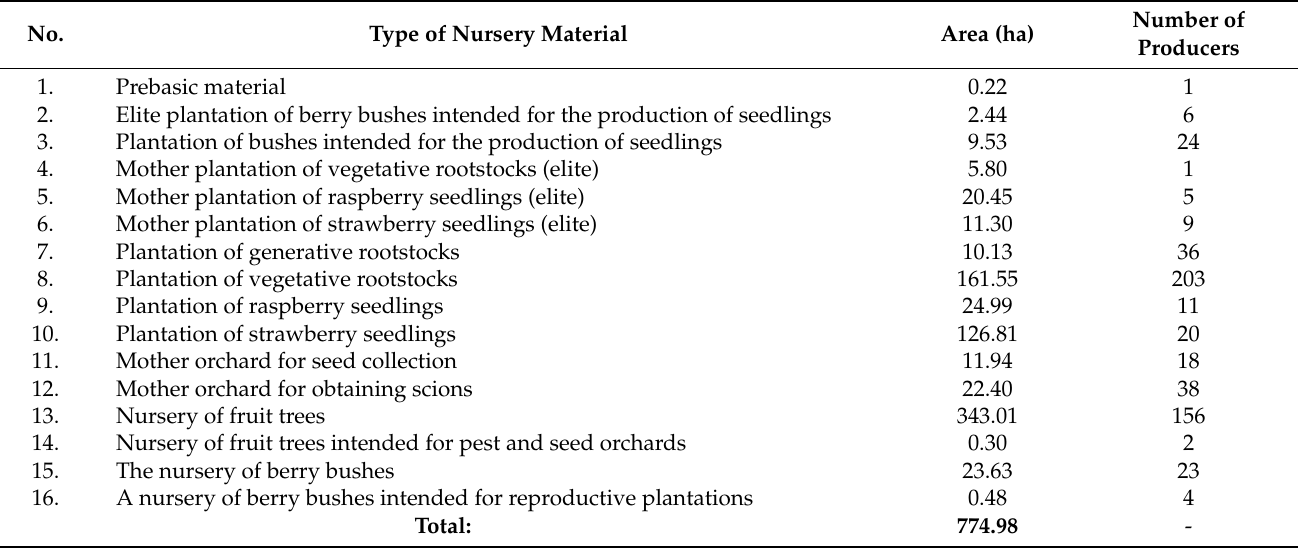
Table 1. Area of eligible nursery crops in 2019 by type of nursery material and number of producers in Poland [59].